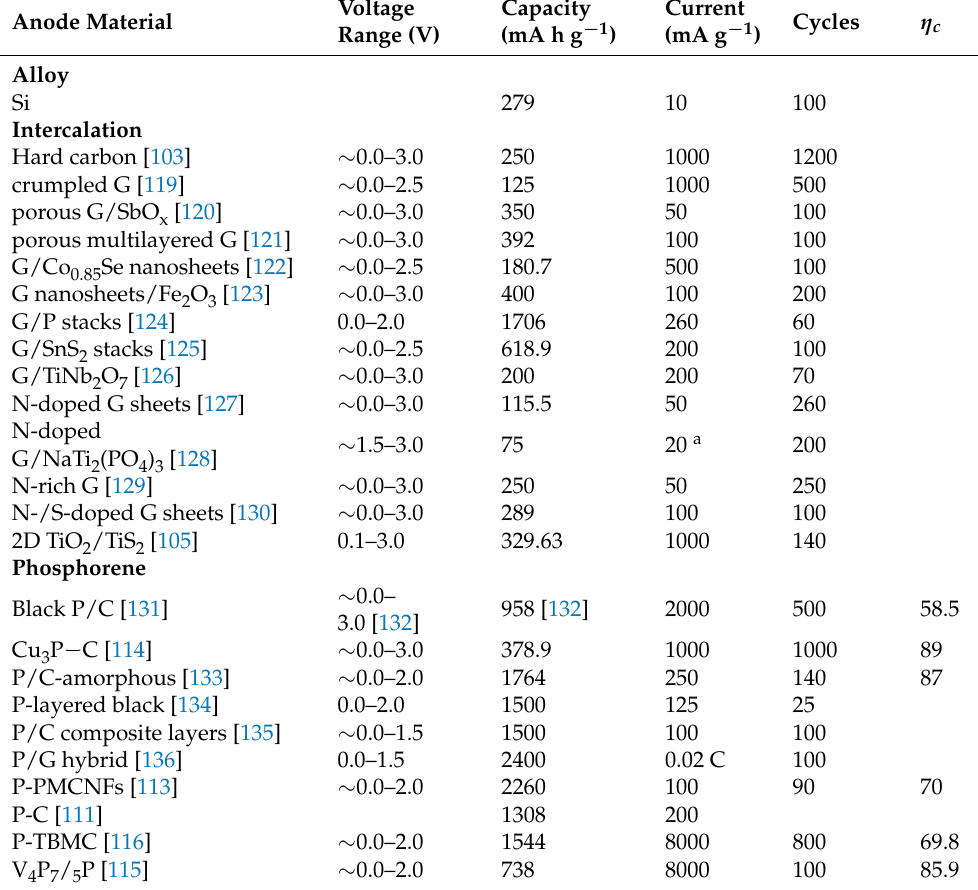
Table 3. Anode materials for Na-based